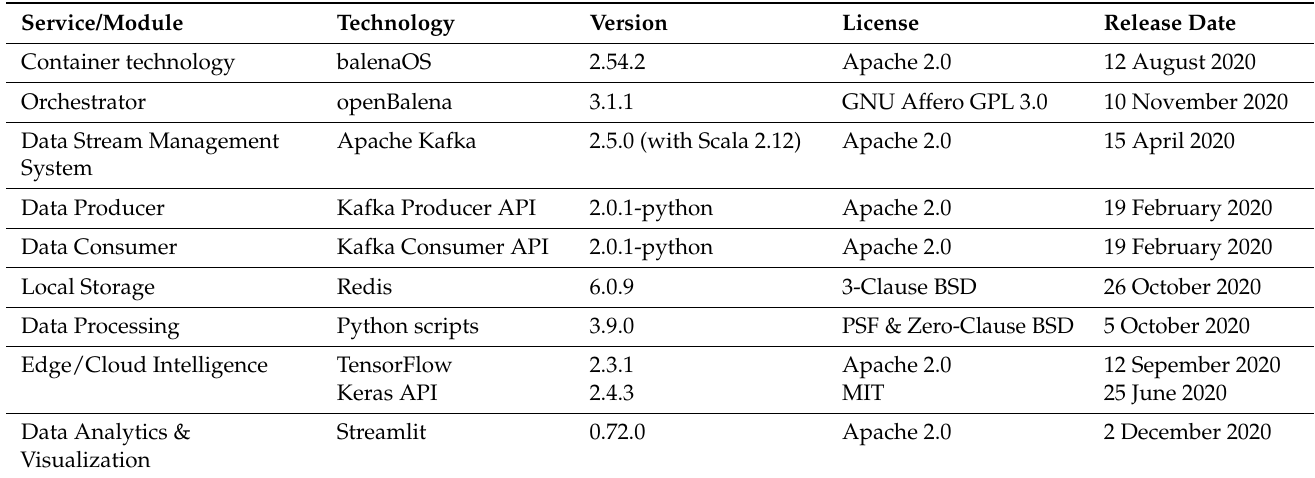
Table 2. Reference COTS